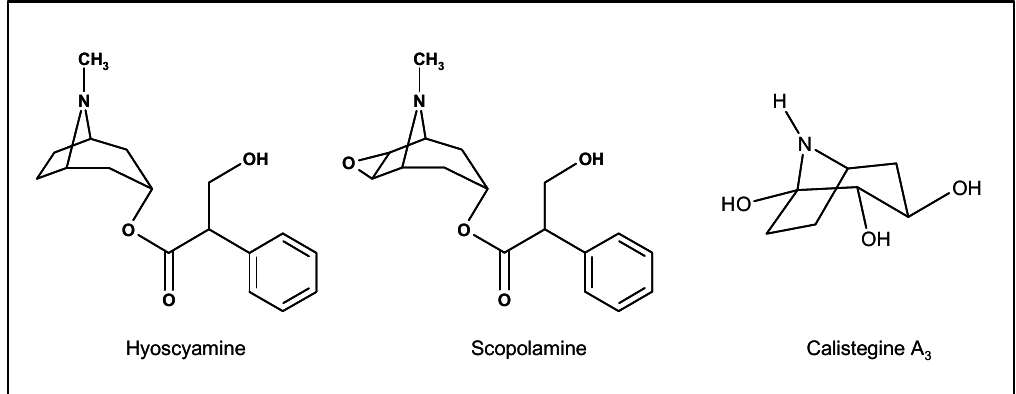
Figure 1. Chemical structures of the anticholinergic alkaloids hyoscyamine, scopolamine and calystegine